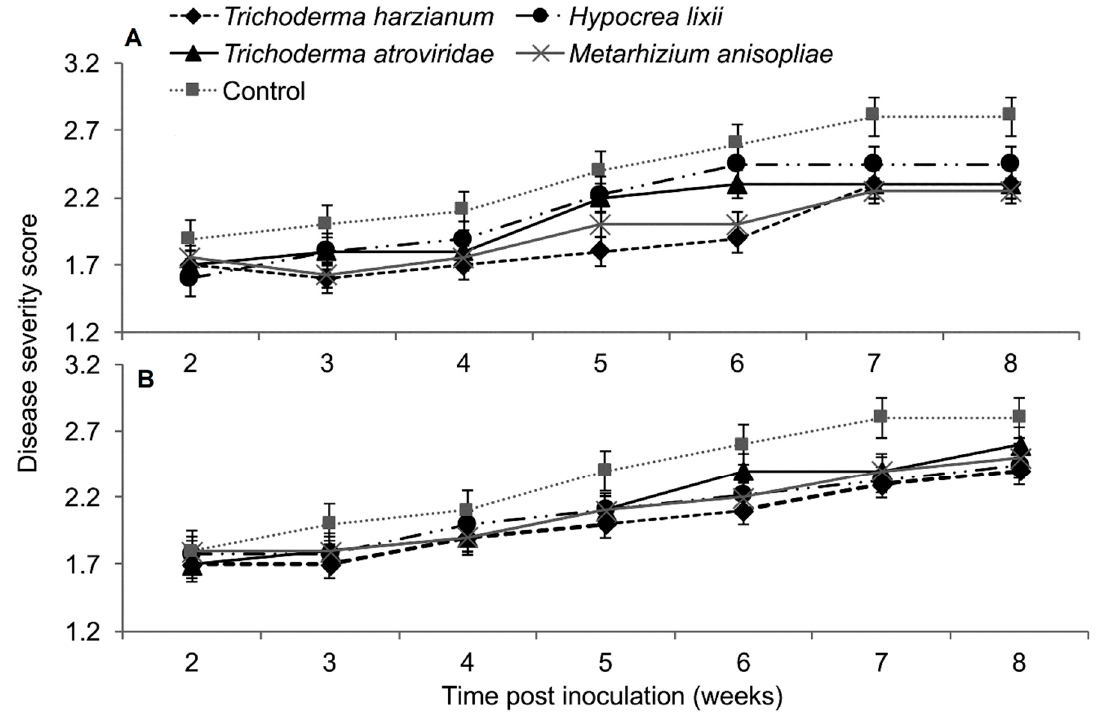
Figure 8. Severity of Maize chlorotic mottle virus disease as influenced by different treatments of fungal isolates over time in trials one ( A ) and two ( B ). Challenge inoculation with MCMV was conducted 21 days after planting.